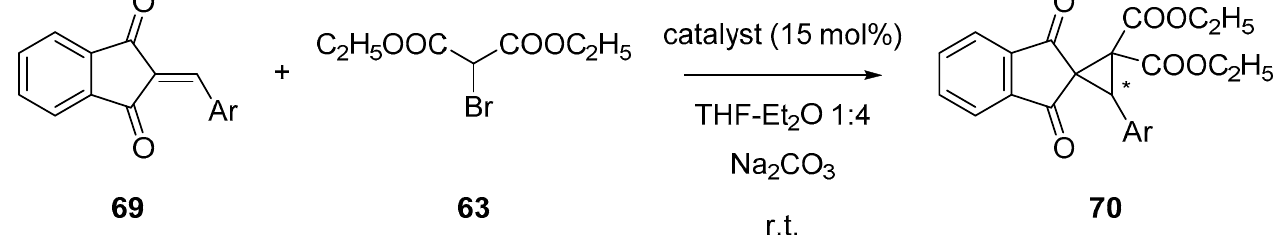
Scheme 16. Michael-initiated ring closure reaction of arylidene indane-1,3-diones ( 69 ) and diethyl bromomalonate ( 63 ).